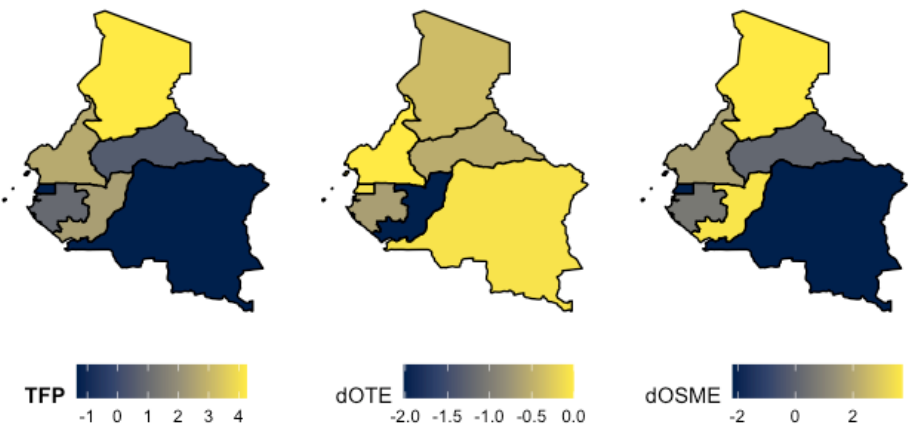
Figure 3. Agricultural productivity growth in Central Africa as shown by TFP and components of TFPE, 2000–2016. Note: dTFP = Productivity Change, dOTE = Technical Efficiency Change and dOSME = Scale-Mix